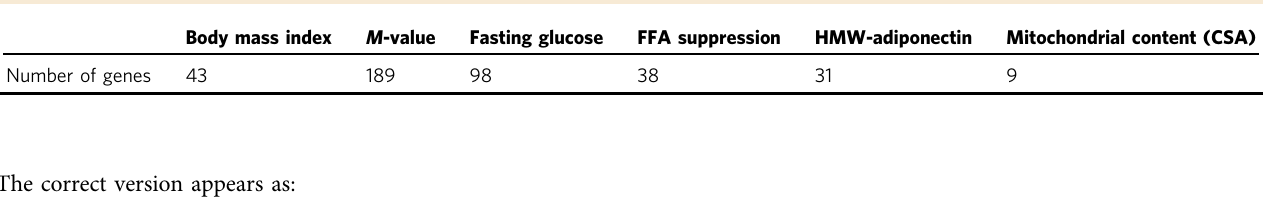
Table 3 Number of genes differentially expressed and methylated at 52 and exhibiting at least one CpG signi fi cantly correlated to the indicated clinical parameters.